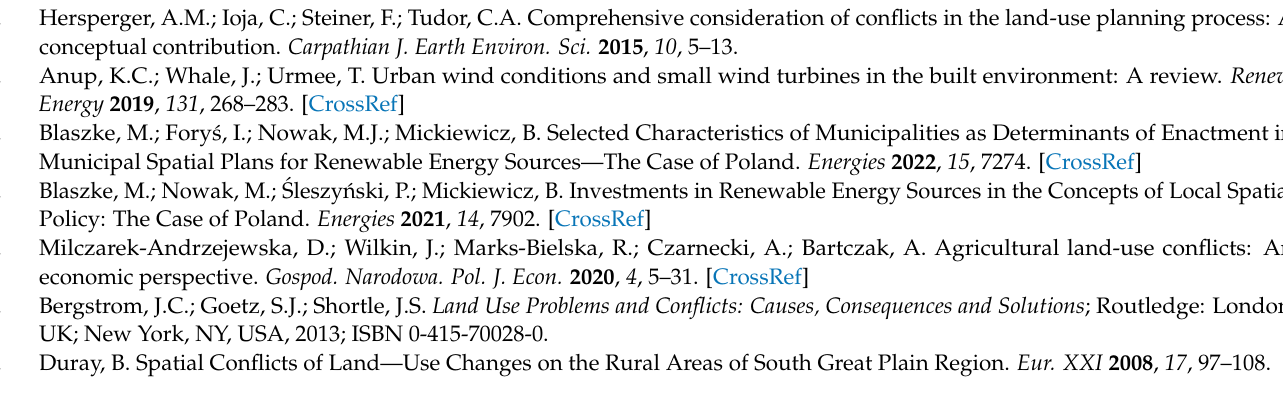
Figure A2. Municipalities whose representatives responded to the research questions.